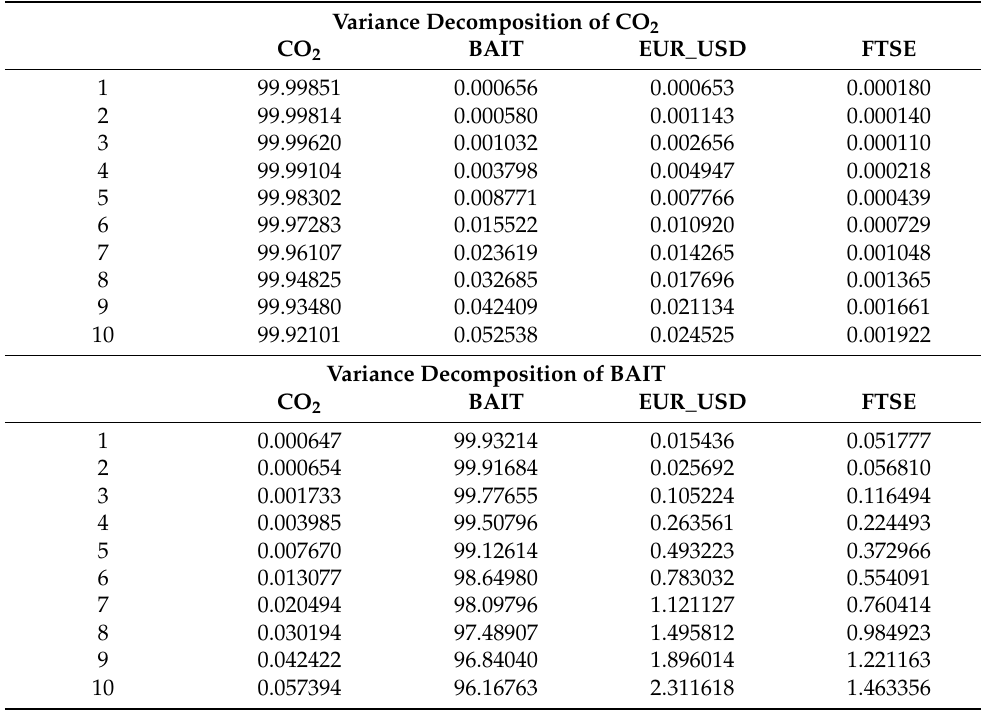
Table 3. Forecast Variance Decomposition (FVD) for a ten-time period